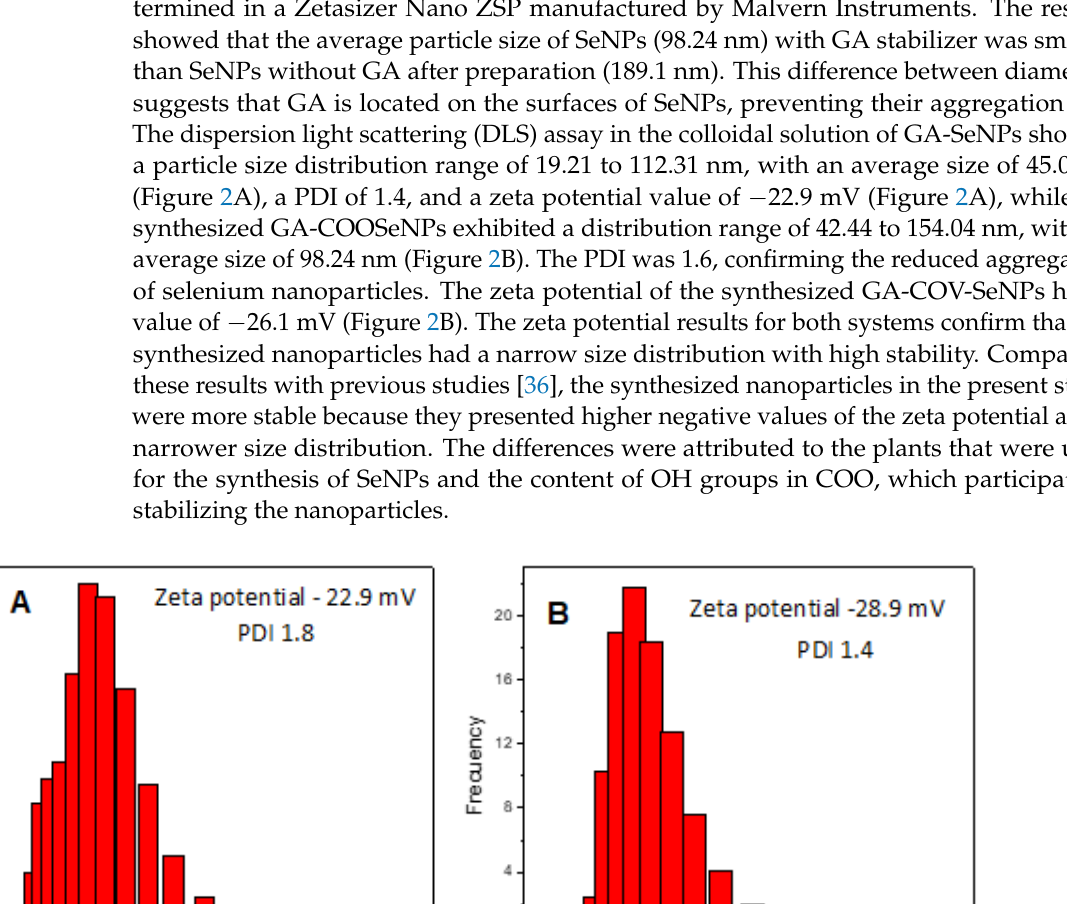
Figure 3. High-resolution transmission electron microscopy (TEM) images of SeNPs at 20 and 5 nm. ( A ) SeNPs derived from the COO depicting spherical nanoparticles ( B ) with bar scales of 20 and 10 nm. 2.5. UV–Visible Spectra SeNPs formation was observed by the color change when the SeO 2 reacted with the ascorbic acid and was monitored by UV–Vis. The participation of GA as a stabilizer at a concentration of 0.5% was evaluated, with the UV–Vis spectra of the colloidal dispersions being recorded, using GA as a blank. TEM images demonstrated that the presence of GA plays an important role in the formation and stability of both dispersion systems of SeNPs. The UV–Vis spectra of COO SeNPs and GA-COO-SeNPs are shown in Figure 4. The COO extract displayed wide absorption bands in the range of 200–450 nm. This band is not